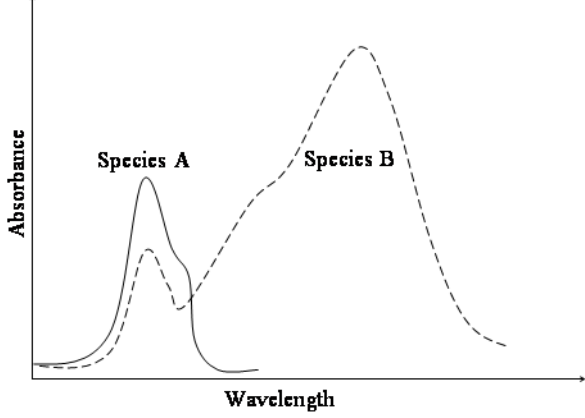
Figure 1. Typical absorption spectra for AB photochromic or thermochromic